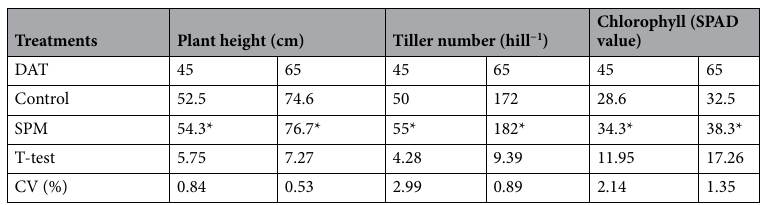
Table 4. Effect of spermine on plant height, tiller number and chlorophyll content in IADA BLS at different days after transplanting. T-test was performed at P ≤ 0.05. *: Significant at P ≤ 0.05. DAT: Days after transplanting, IADA BLS: Integrated Agricultural Development Authority Barat Laut Selangor and CV: Coefficient of variation.